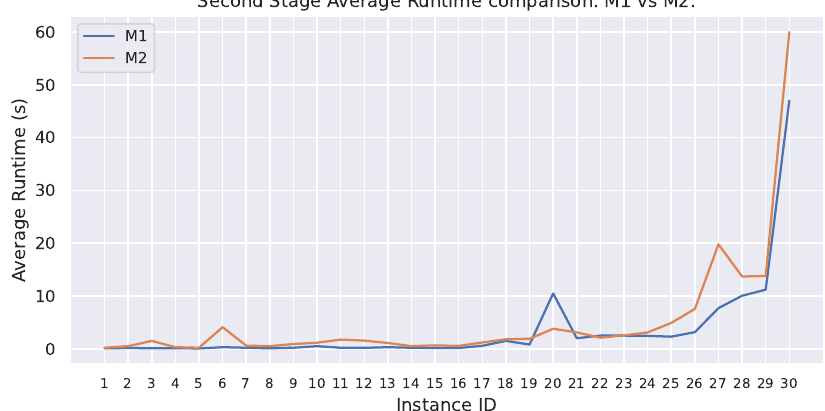
Figure 17. Second stage execution time comparison, depending on the first stage